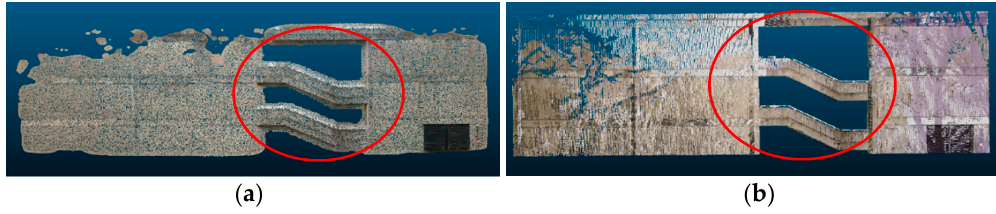
Figure 15. Example of a Poisson reconstruction limitation. ( a ) Side of a building after reconstruction and ( b ) target ground truth.